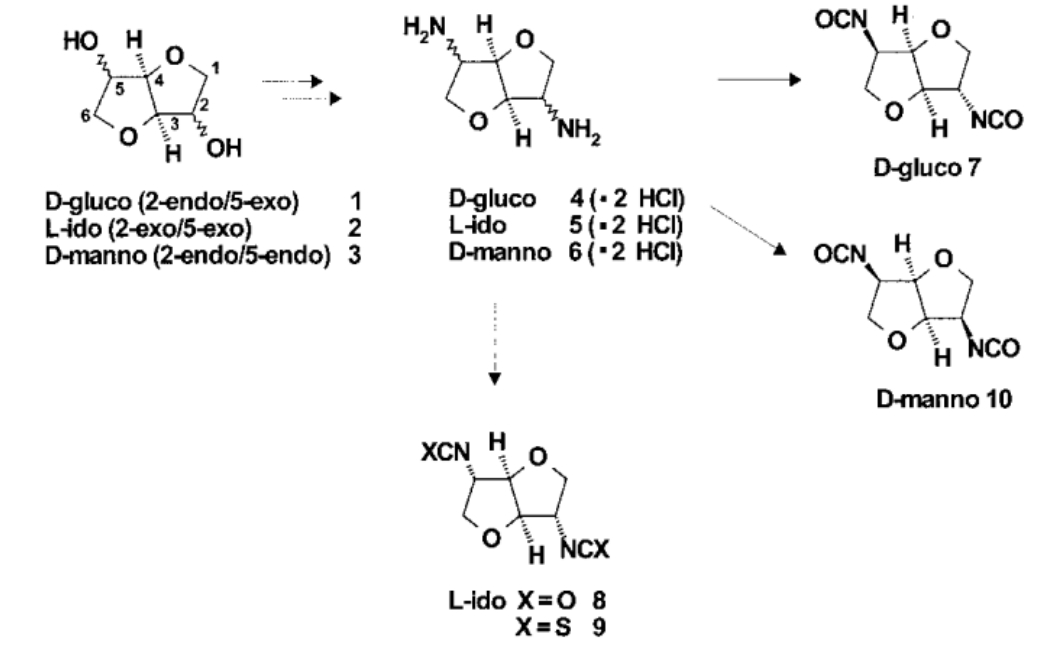
Figure 26. Monomer synthesis. From reference [57].